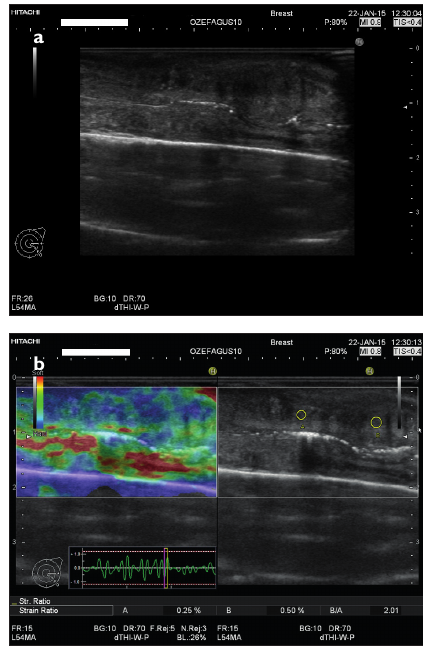
Figure 1. a, b. B-mode sonography (a) of an esophageal specimen showing a tumor on the side closest to the probe (arrow). The bright area represents air in the lumen. On the sonoelastography image (b), the tumor shows stiff areas (blue) compared to the muscle tissue at the same